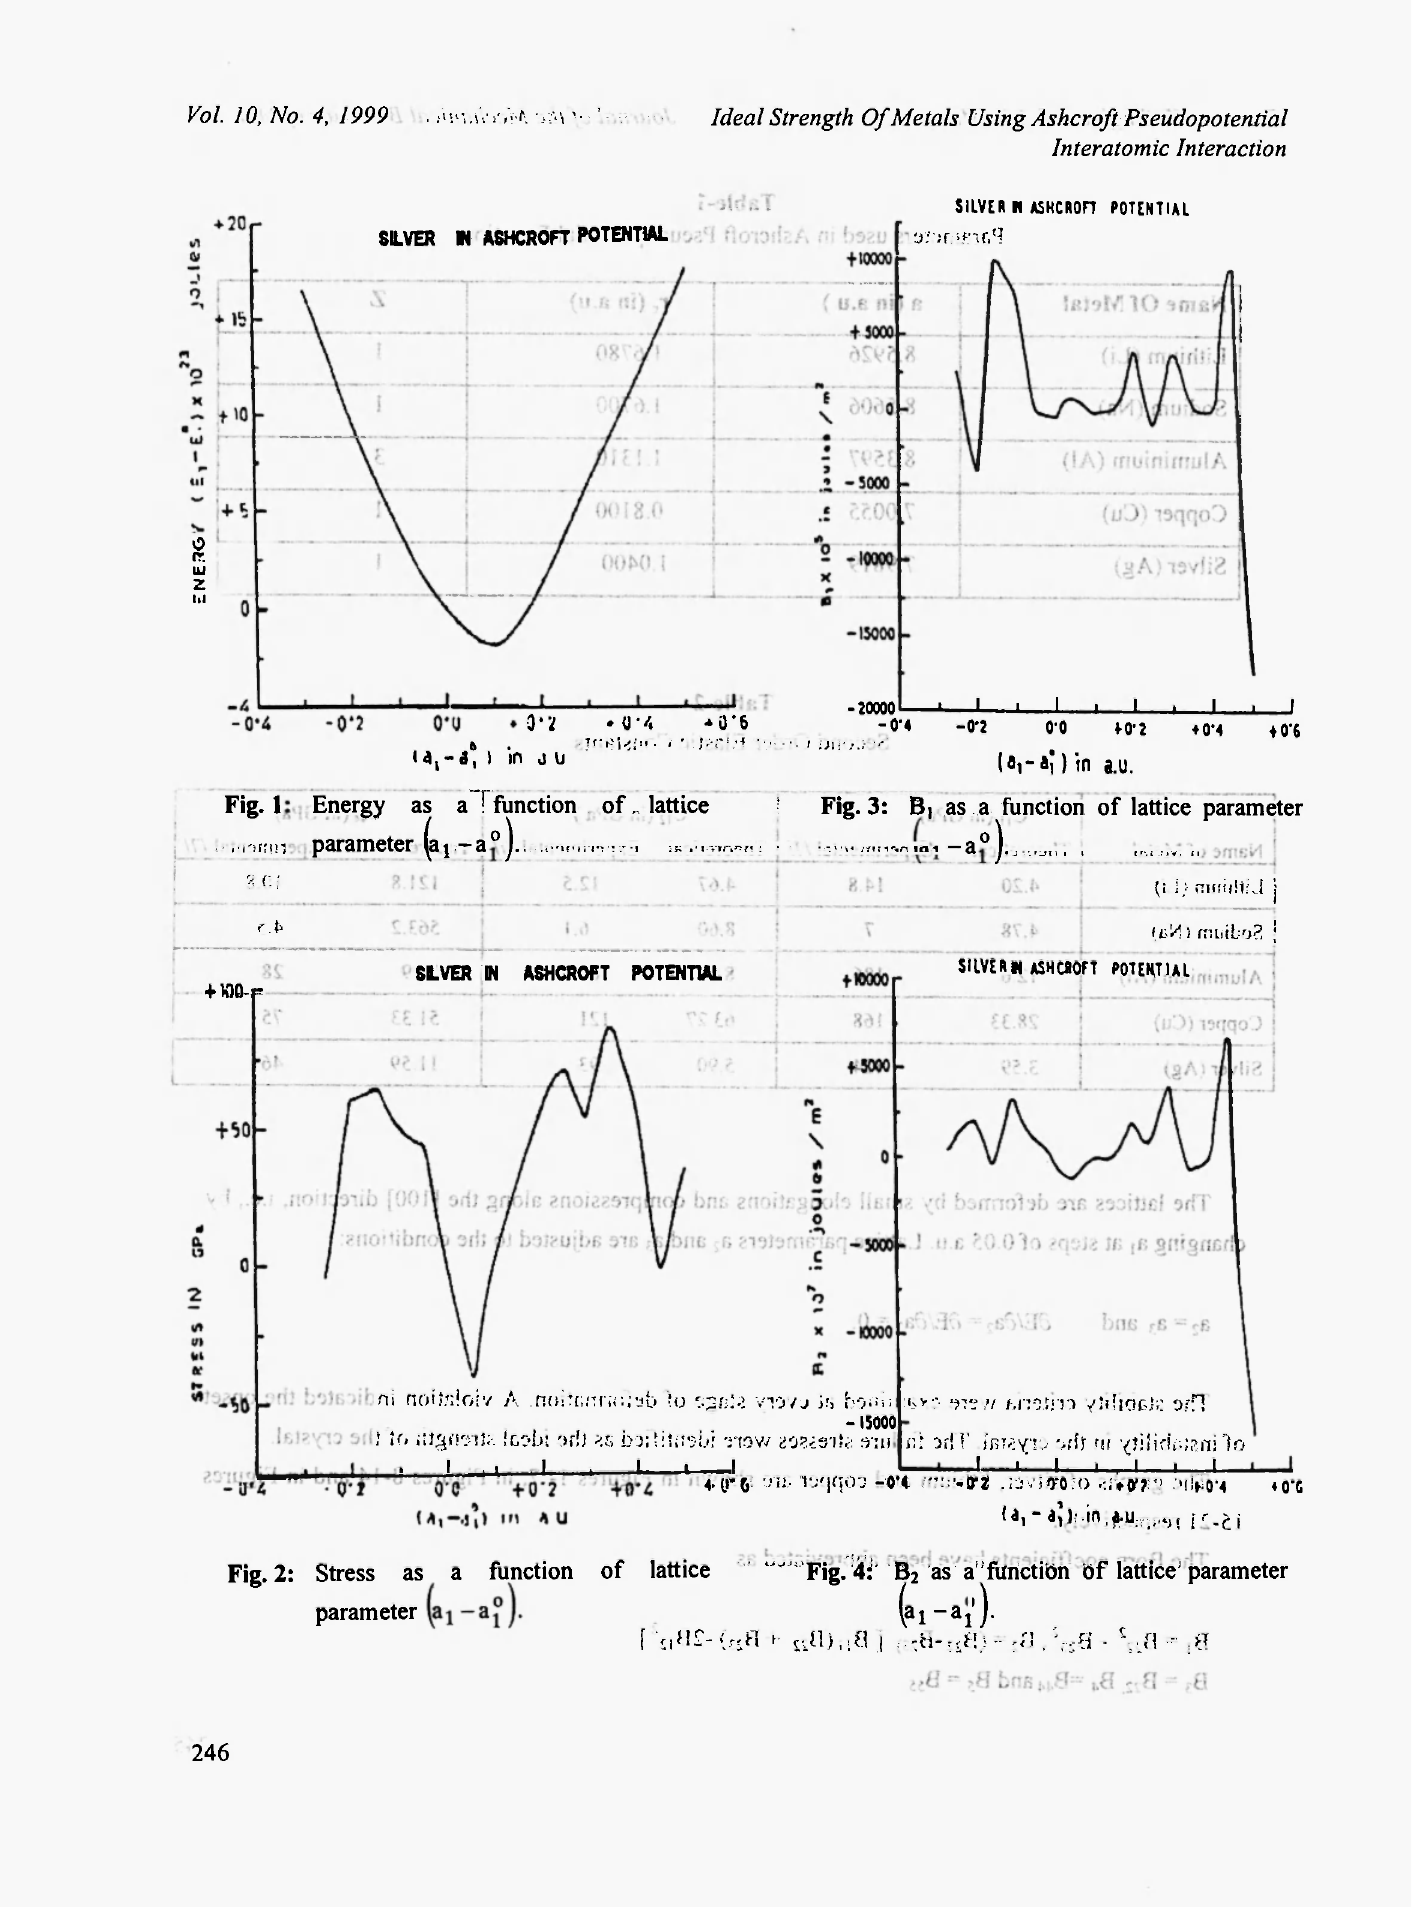
Fig. 3: B, as a function of lattice parameter